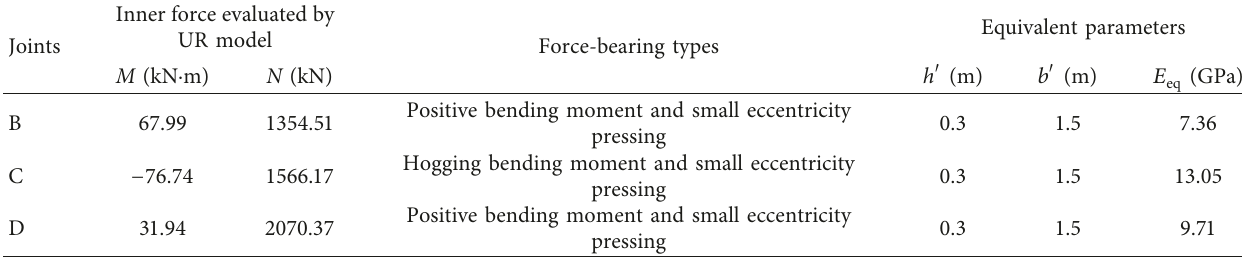
Table 1: Equivalent parameters on joints section.